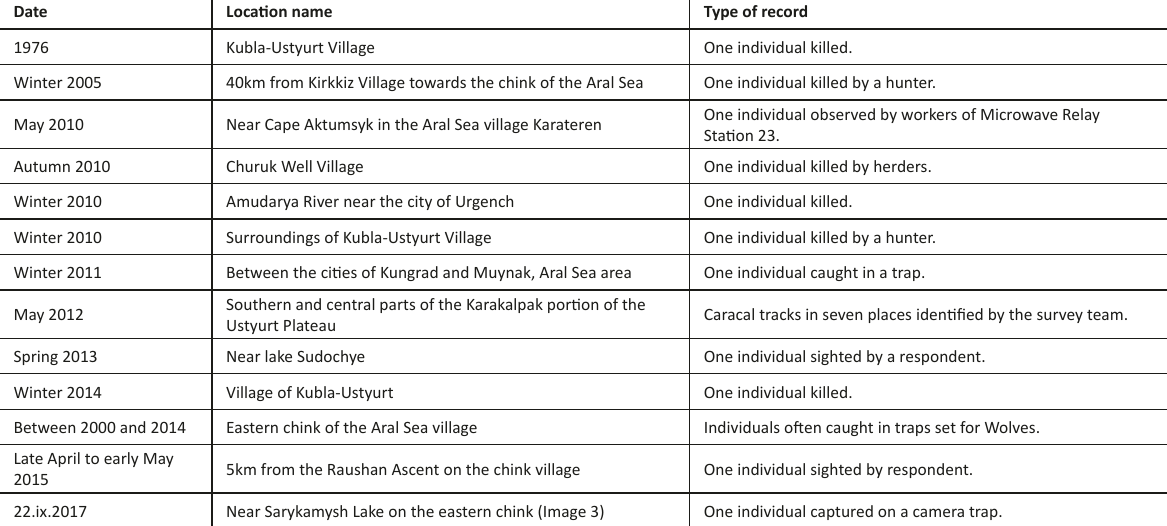
Table 3. Caracal records collected in Ustyurt Plateau during expeditions between 2011 and